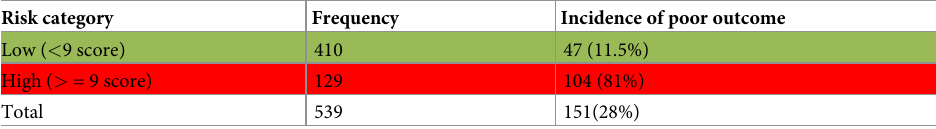
Table 4. Risk stratification for poor outcomes of pneumonia using simplified prediction